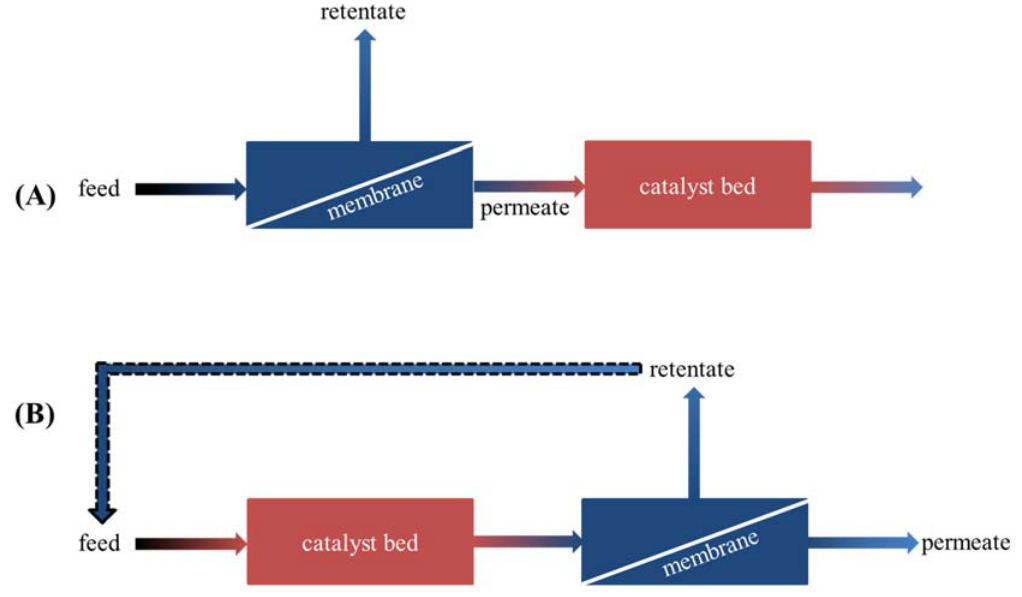
Figure 2. Schematic drawing of different set-ups of zeolite membranes apart from the reaction zone; ( A ) feed treatment; and ( B ) product treatment with optional retentate